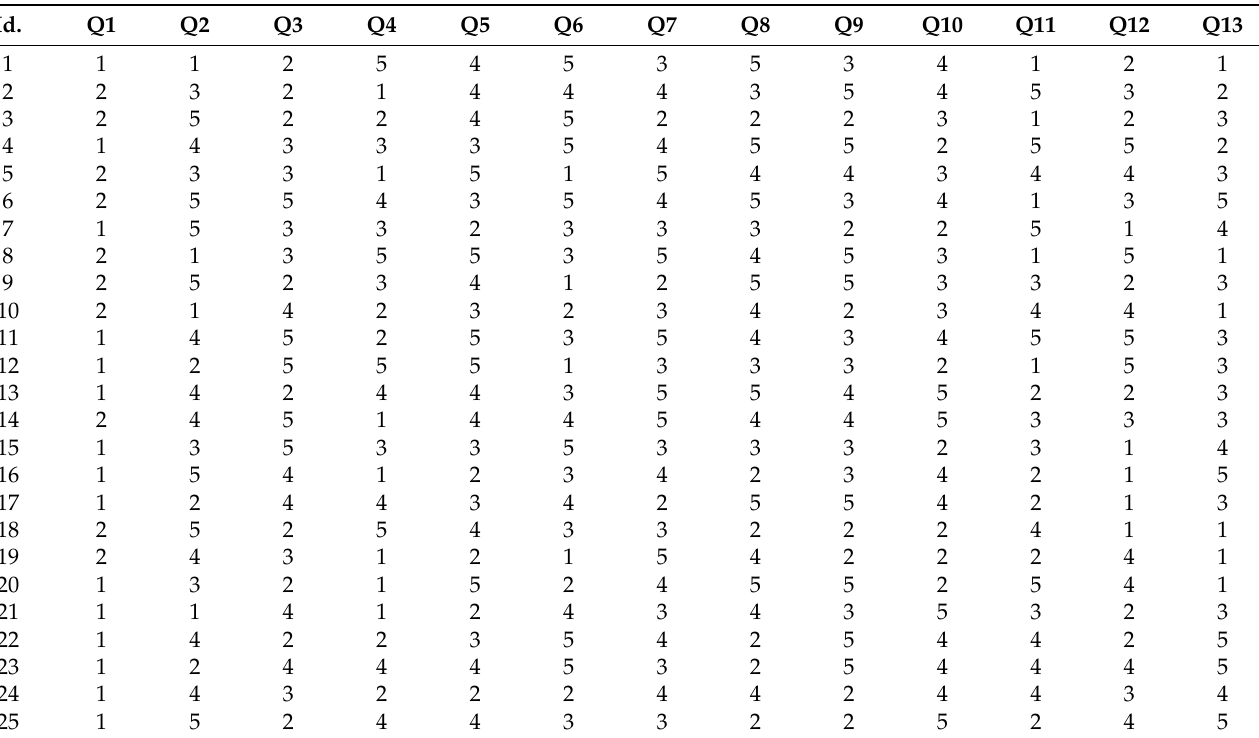
Table 6. Sample of the transformed data from the survey of 2260 students, with 14 columns.